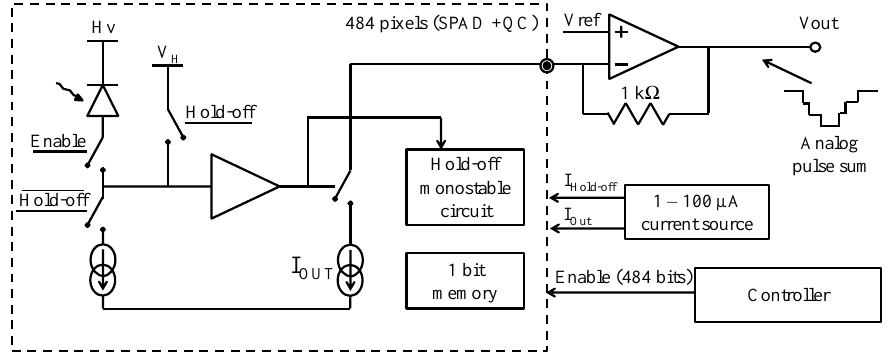
Figure 8. Block diagram of the front-end quenching circuit. A monostable circuit is used to control the hold-off (for afterpulsing mitigation). Also shown, the current source which is triggered when an avalanche is detected. The analog sum of each precise current source is made by a transimpedance amplifier on the printed circuit board. As shown, the current pulse width and height can be tailored.